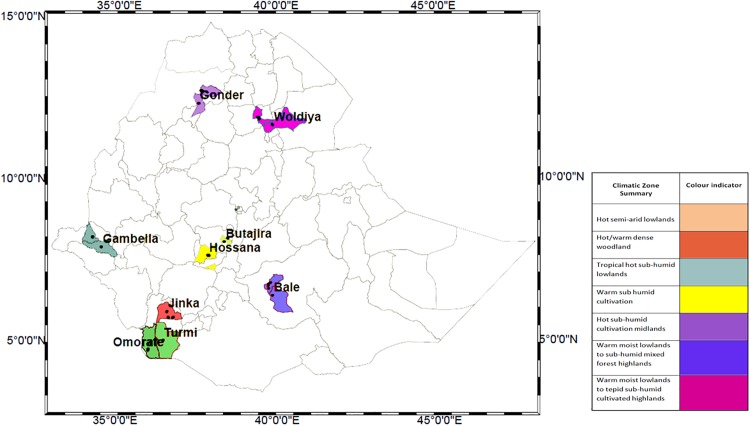
Map of sample collection locations.Map of Ethiopia to show the sampling locations, shaded areas represent climatic descriptions of the nine regions sampled.